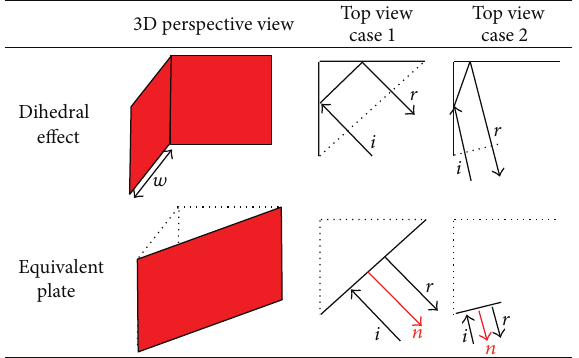
Figure 7: Principle of the equivalent plate model used to reproduce the backscattering